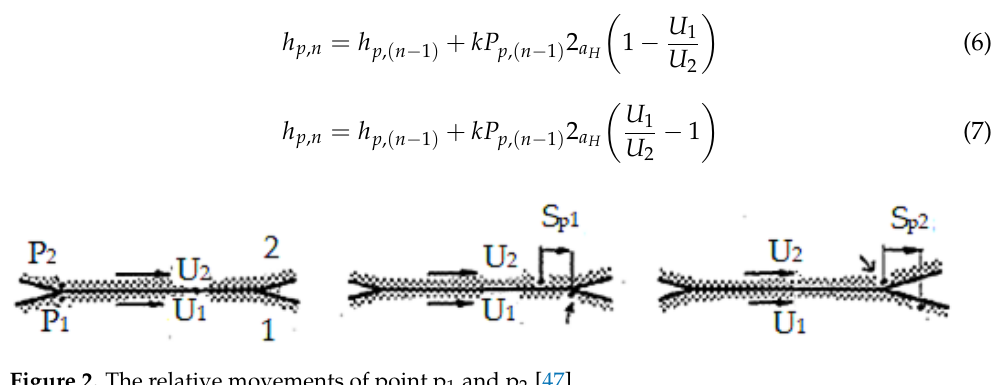
Figure 2. The relative movements of point p 1 and p 2 [47].